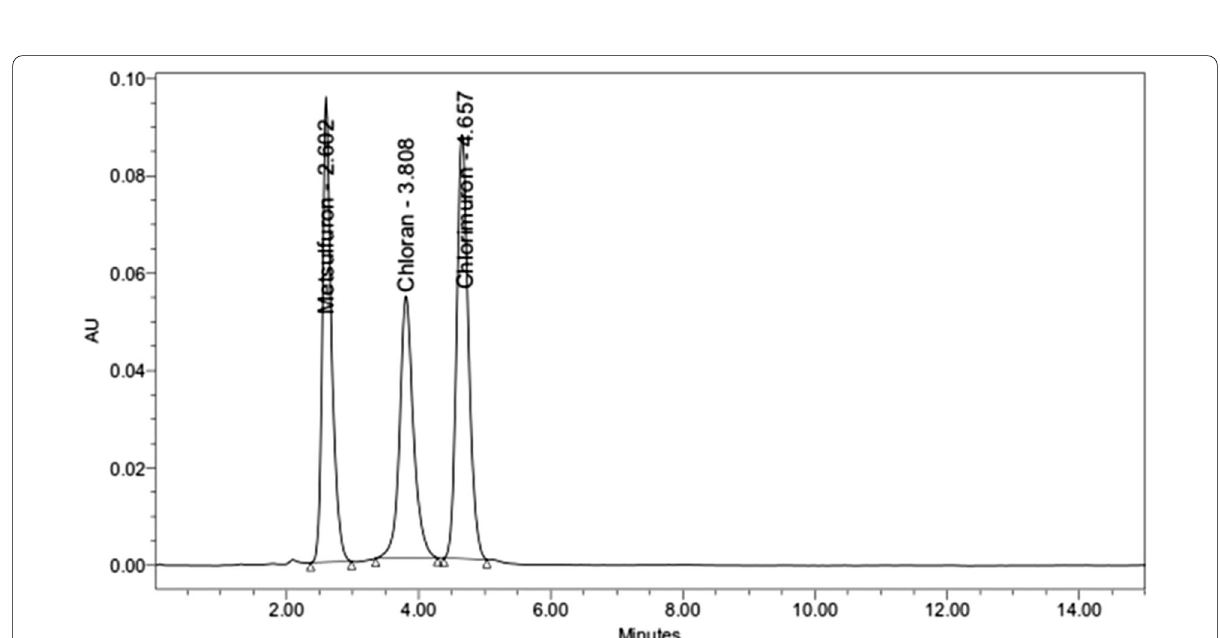
Fig. 8 Chromatogram showing the resolution of metsulfuron-methyl, chlorantraniliprole and chlorimuron-ethyl in sample solution